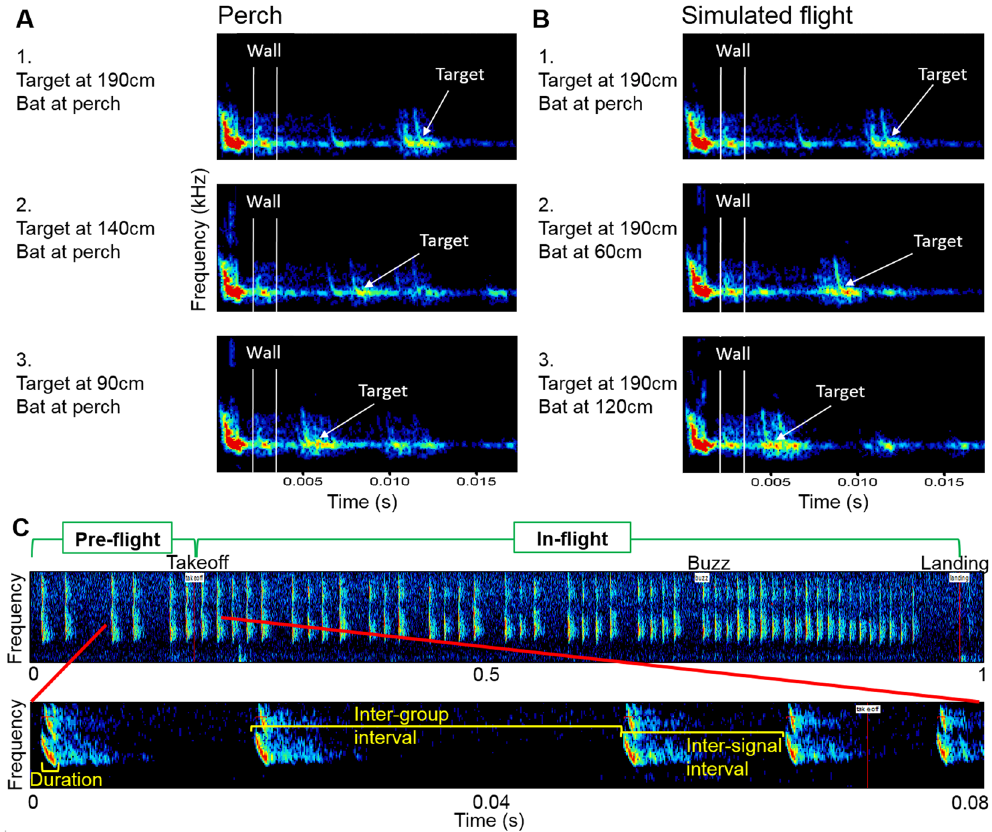
Figure 1. Background vs. target echoes and parameters for analysis. Ensonification of the target and the resulting echoes ( A,B ). Echoes from near background objects reached the bat after 1.7 ms, before those of the target. From the perch (takeoff point) ( A ), the echoes from the side walls (between white lines) reached the bat well before target echoes (marked by an arrow), whether the target is positioned at 190 cm (A1), 140 cm (A2) or 90 cm (A3). The same is true along a simulated flight path ( B ) to a target (positioned at 190 cm) from takeoff point (B1), after 60 cm of flight (B2) and after 120 cm of flight (B3). Though background echoes appear weaker than target echoes, this is a result of the higher directionality of the speaker compared to a bat’s echolocation beam (see methods). ( C ) Acoustic parameters used for analysis: Spectrogram of a typical flight’s echolocation sequence (top), beginning on the wall before takeoff. Notice the buzz- the terminal sequence of signals emitted right before contact with a target (the word ‘ Buzz ’ marks its initiation), before the landing (depicted at the end). Enlarged (bottom) is a segment containing the takeoff, illustrating the parameters analyzed in the study: signal duration, interval between signal groups (inter-group interval, used for pre-takeoff analysis) and interval between signals (inter-signal interval, used for in-flight